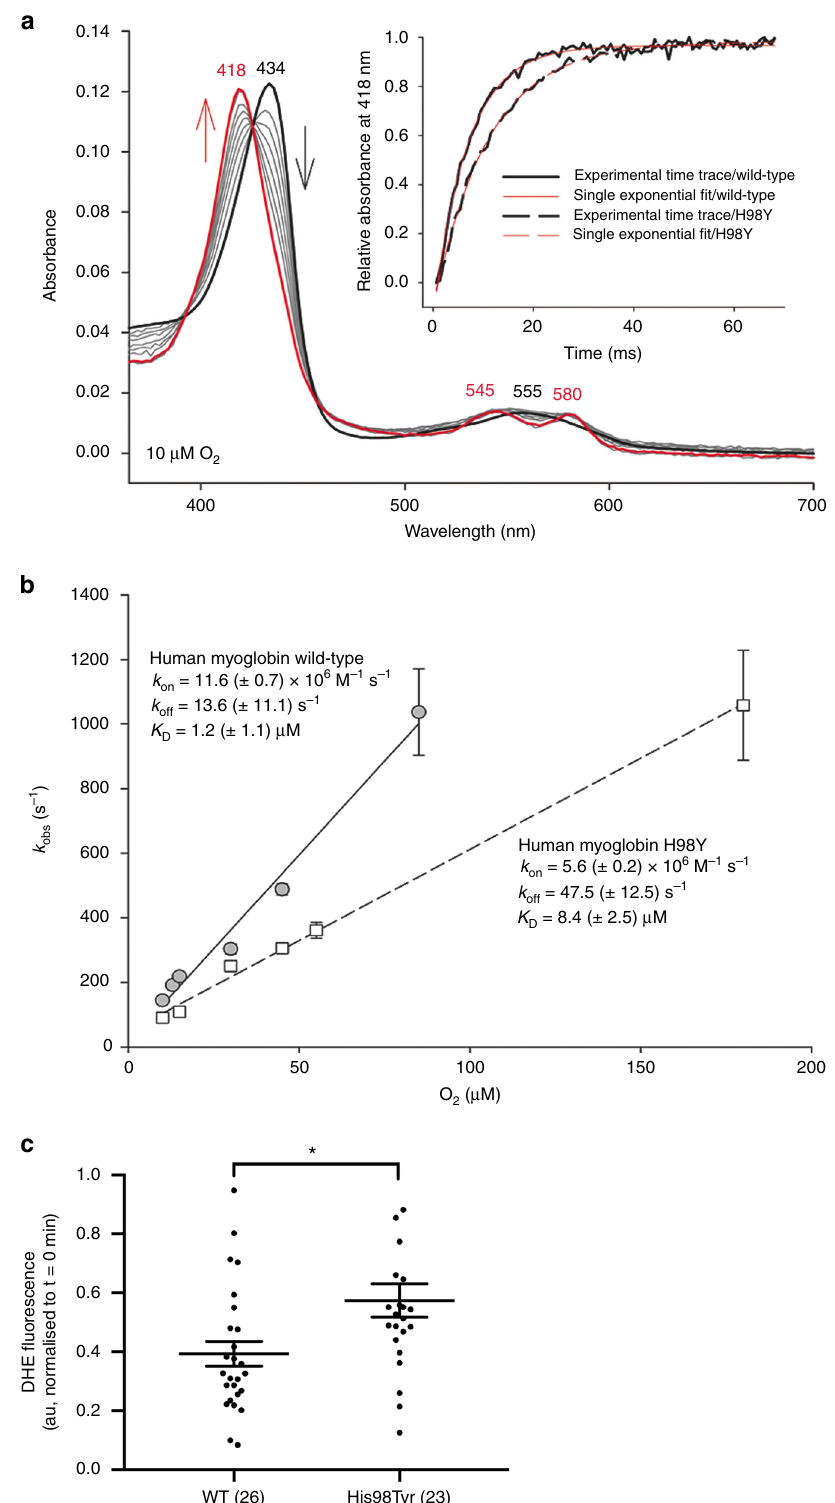
Fig. 7 Kinetics of dioxygen binding to wild-type human myoglobin and the variant His98Tyr. a Spectral changes upon reaction of 1 µ M ferrous wild-type hMb (black line) with 10 µ M O 2 . The fi nal spectrum represents oxymyoglobin (red line, 68 ms after mixing). Gray lines represent spectra obtained at 0.68, 2.72, 4.08, 6.12, 8.84, 12.24, 34.00, and 51.00 ms after mixing. The inset depicts experimental time traces at 418 nm of wild-type hMb (solid black line) and p.His98Tyr MB (dashed black line) mixed with 10 µ M O 2 and corresponding single-exponential fi ts (solid red line, wild-type MB; dashed red line, His98Tyr MB). b Linear dependence of k obs values from the O 2 concentration for wild-type MM (gray circles, solid line) and p.His98Tyr MB (white squares, dashed line). c Basal intracellular superoxide levels in HEK293FT cells expressing WT or mutant MB-EGFP. Data presented as individual data points and the mean ± SEM, numbers in parenthesis represent n . *indicates p = 0.007 (Mann – Whitney test,